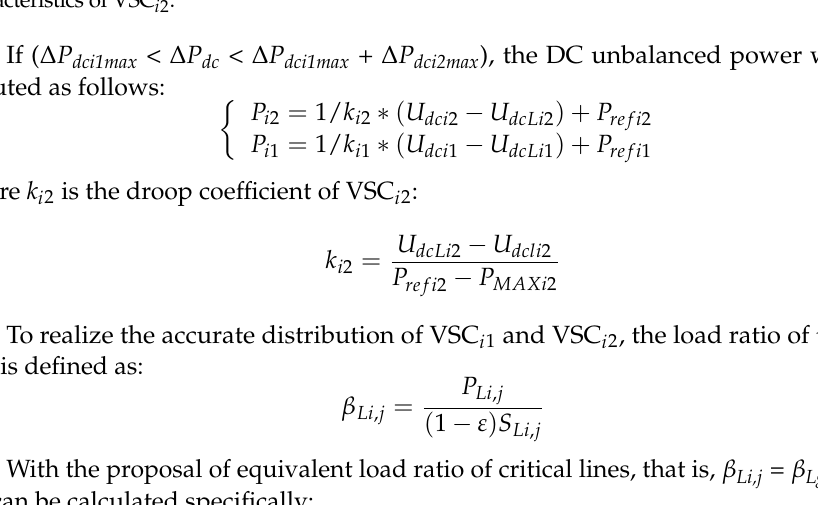
Figure 5. Control characteristics of shared control mode. ( a ). U dc-P characteristics of VSC i1 . ( b ). U dc-P characteristics of VSC i2 .